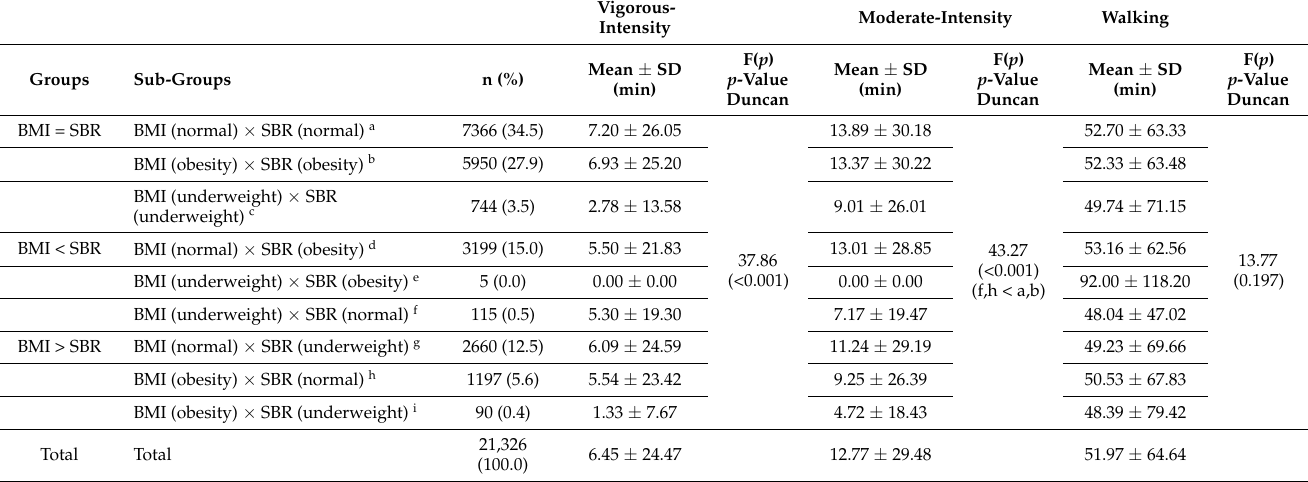
Table 3. Comparison of exercise time in each body image perception and actual weight status group according to exercise